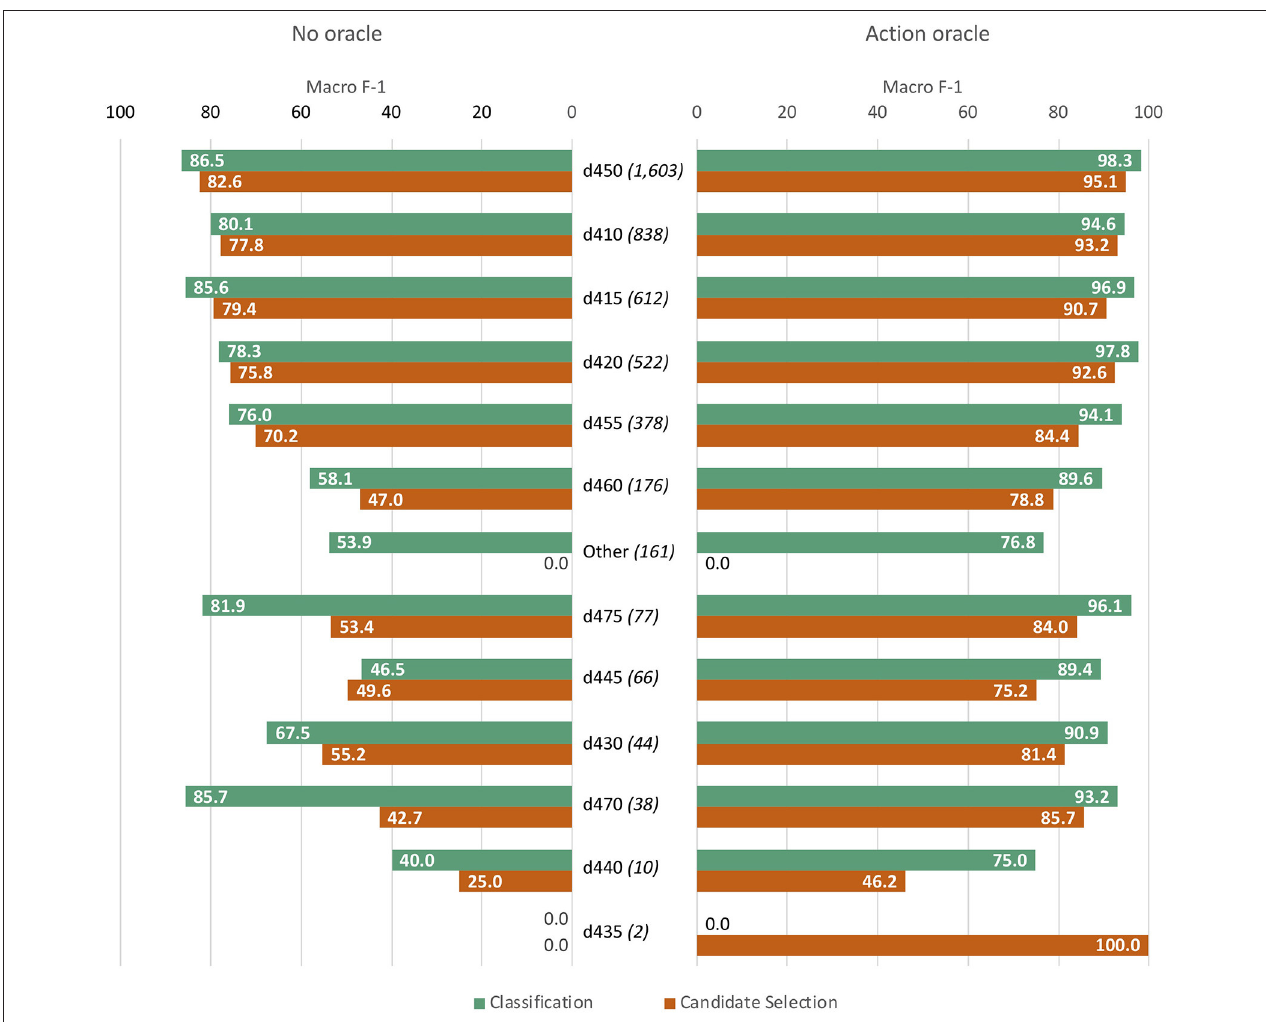
FIGURE 8 | Per-label performance analysis, comparing best classification and candidate selection models without access to the Action oracle (left bars) and with oracle access (right bars). Labels are ordered from most frequent ( d450 ) to least ( d435 ), with the frequency of each provided in